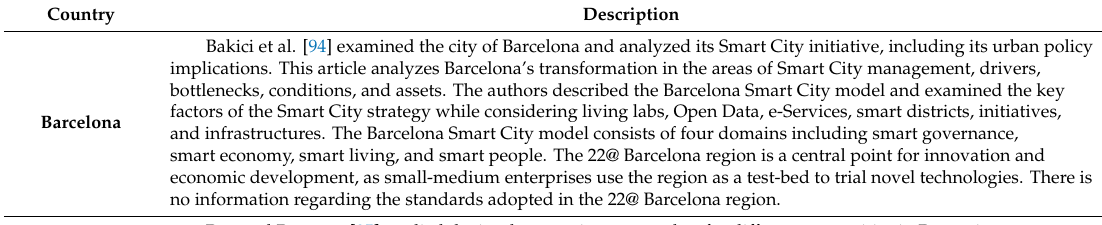
Table 8. Smart cities pilot projects in